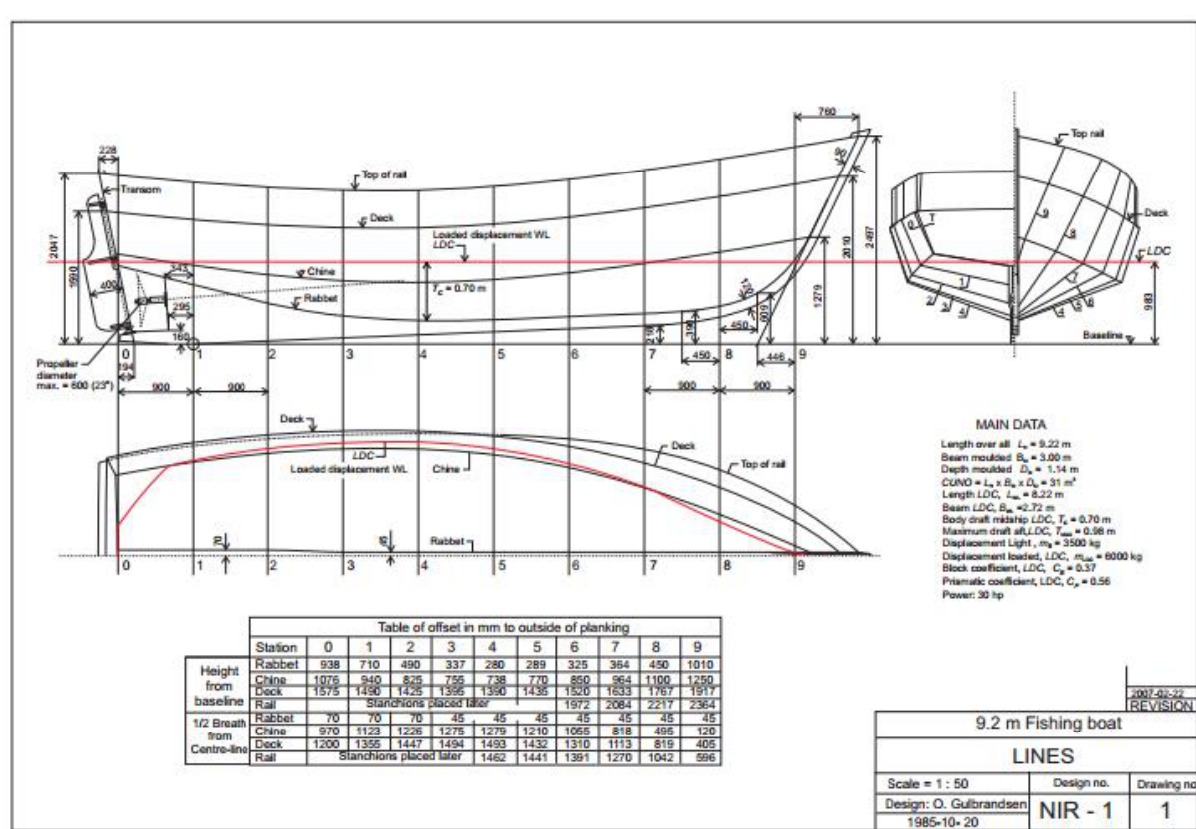
Figure 8. Example 1 lines drawing (FAO1), LOA = 9.22 m, BOA = 3.00 m.